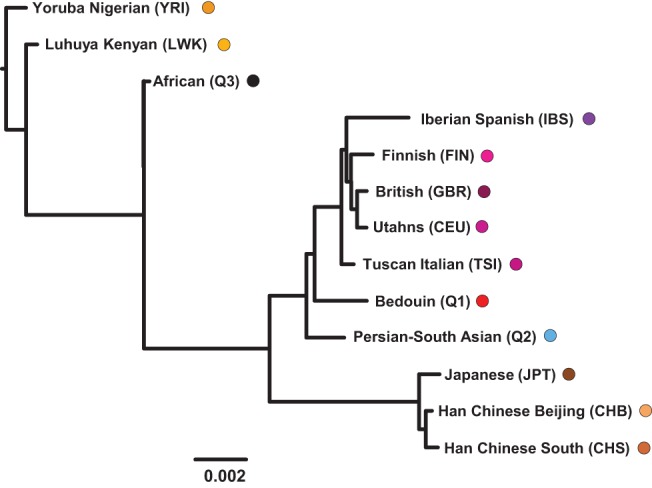
TreeMix (Pickrell and Pritchard 2012) hierarchical clustering analysis of the Q1 (Bedouin), Q2 (Persian-South Asian), and Q3 (African) and the 1000 Genomes Project samples. Shown is a maximum-likelihood tree of population splits inferred without subsequent migration events, in which branch lengths estimate divergence between populations (Europeans in shades of purple: CEU, FIN, GBR, IBS, TSI; East Asians in shades of brown: CHB, CHS, JPT; Africans in shades of orange: LWK, YRI, with the Q1 [Bedouin] in red, Q2 [Persian-South Asian] in azure, and Q3 [African] in black). When allowing from one to five migration events in separate TreeMix analyses, none of the admixture loops connected the Q1 (Bedouin) with any African populations (Supplemental Fig. 10), consistent with the Q1 (Bedouin) having no recent African admixture.